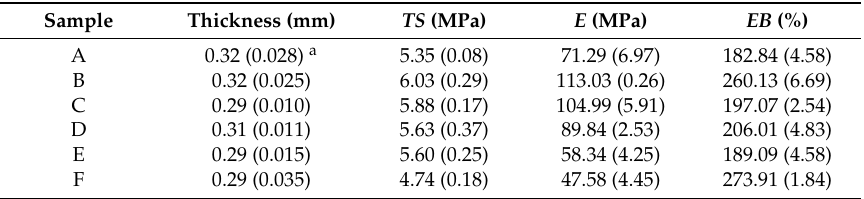
Table 3. The thickness, tensile strength ( TS ), Young’s modulus ( E ) and elongation at break ( EB ) of different SPI-based films.